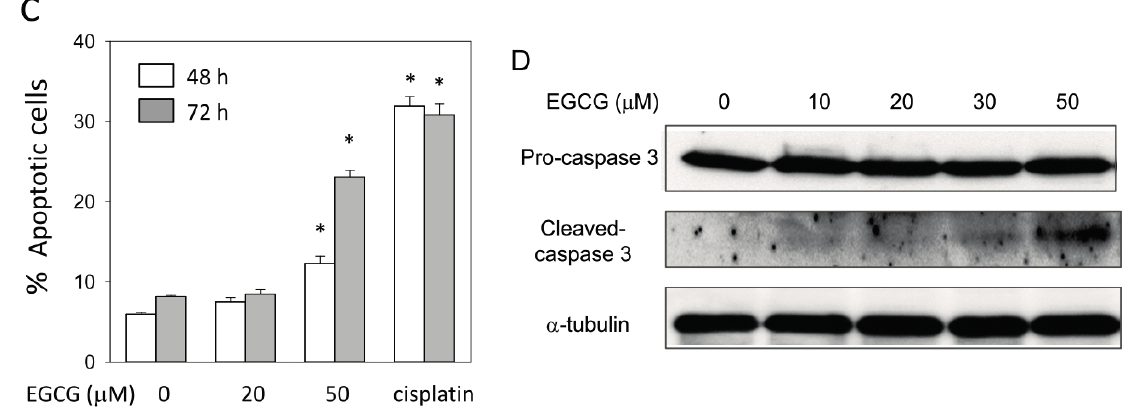
Figure 7. EGCG up-regulates the expression of p53 and p21, and induces apoptosis of NPC cells via caspase 3 activation. NA cells were treated with various concentrations of EGCG for the times indicated. ( A ) Western blot analysis of p53 and p21 in NA cells at 24 and 48 h. α -tubulin is detected as a loading control; ( B ) The apoptosis of NA cells was quantified using flow cytometry after staining with annexin-V and PI. Cisplatin-treated (5 μ M) cells were included as a positive control for apoptosis. Representative scatter plots of annexin-V ( x -axis) and PI ( y -axis) were shown. Each dot on the plot represents a count event in cytometry analysis; ( C ) The percentage of apoptotic cells was summed up by the percentage of stained cells in the upper and lower right panels of the scatter plot. Data indicate the value of mean ± SD. *: p < 0.05, compared to the mock-treated cells; ( D ) Western blot analysis of cleaved caspase 3 after 24 h of EGCG treatment. α -Tubulin is detected as a loading